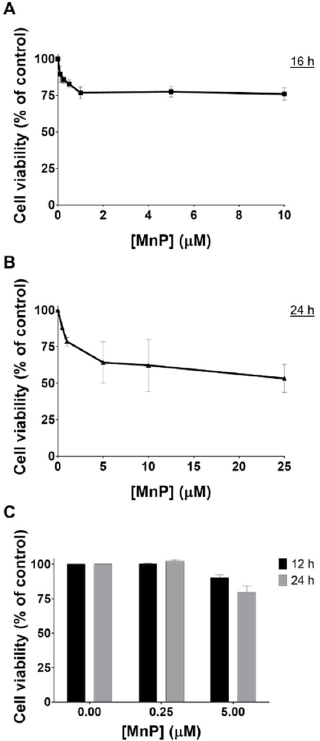
Figure 1. Cytotoxic effects of MnP (0.1–25 μM) in 786-O cells with 2% FBS. The viability of MnP-exposed cells (12–24 h) was evaluated by CV ( A and B ) and MTS ( C ) assays. Values represent mean ± SD (n = 2–3) and are expressed as percentages of the non-treated control cells.